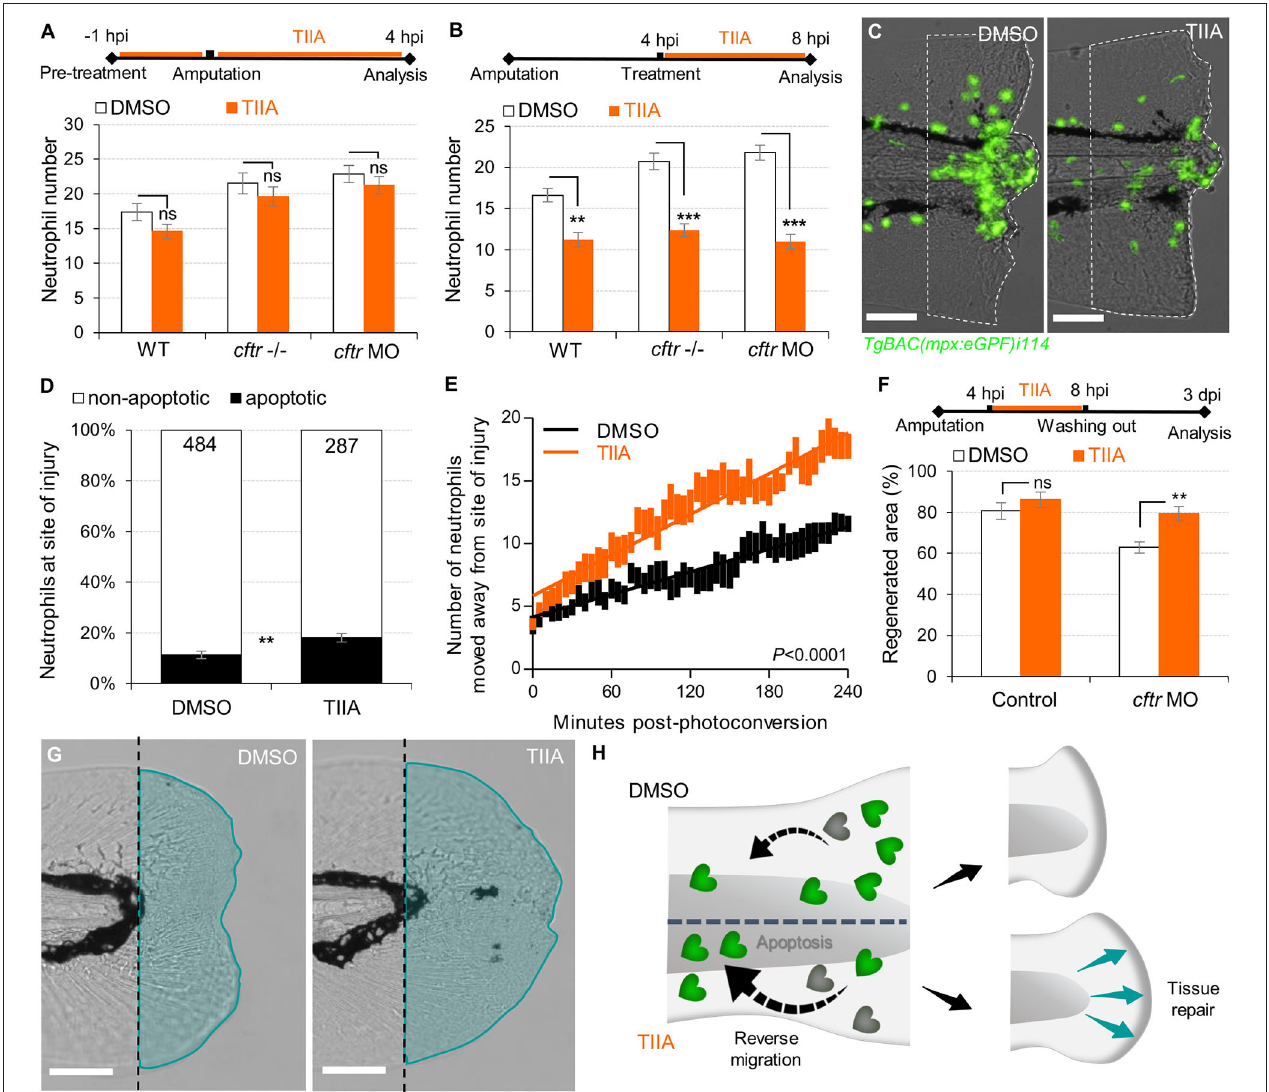
FIGURE 5 | TIIA-driven neutrophil apoptosis and reverse migration accelerate inflammation resolution in CF. (A) TgBAC(mpx:EGFP)i114 larvae were pretreated with 25 µ M of TIIA prior to tail fin amputation procedure, then injured and immediately put back in treatments for 4h. Neutrophil number at the wound was counted at 8 hpi ( n = 21, two-tailed Bonferroni t -test). (B,C) TgBAC(mpx:EGFP)i114 larvae were injured and treated from 4 hpi with 25 µ M of TIIA. (B) Neutrophil number at wound was counted at 8 hpi ( n = 21, two-tailed Bonferroni t -test). (C) representative number of neutrophils remaining at wounds at 8 hpi (scale bars, 200 µ m). (D) Neutrophil apoptosis quantification at 8 hpi in cftr MO treated with 25 µ M of TIIA from 4 hpi and stained with TUNEL/TSA. ( n = 40, Fisher t -test). (E) Reverse-migration assay in cftr MO Tg(mpx:gal4)sh267;Tg(UASkaede)i222 . At 4 hpi fish were treated with 25 µ M of TIIA and neutrophils at site of injury were photoconverted. The numbers of photoconverted cells that moved away from the wound were time-lapse imaged and quantified over 4h. (F,G) Regenerative performance after TIIA treatment. (F) Regenerated fin areas are measured at 3 dpi ( n = 21, two-tailed Bonferroni t -test). (G) Representative imaging of injured tail fin at 3 dpi (scale bars, 200 µ m).